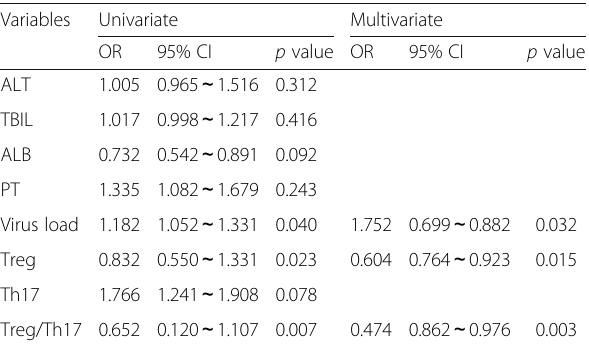
Table 2 Cox regression analysis of the risk factors in patients of